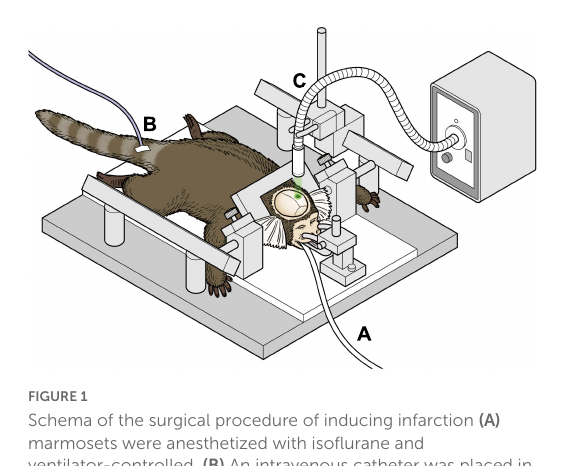
FIGURE2 MarmoDetector (A) the cage was 525 mm long, 356 mm wide, and 776 mm high. (B) Video camera was placed 50 cm away in front of the experimental cage. (C) Personal computer including the software module. The three-dimensional location of the marmoset was recorded and